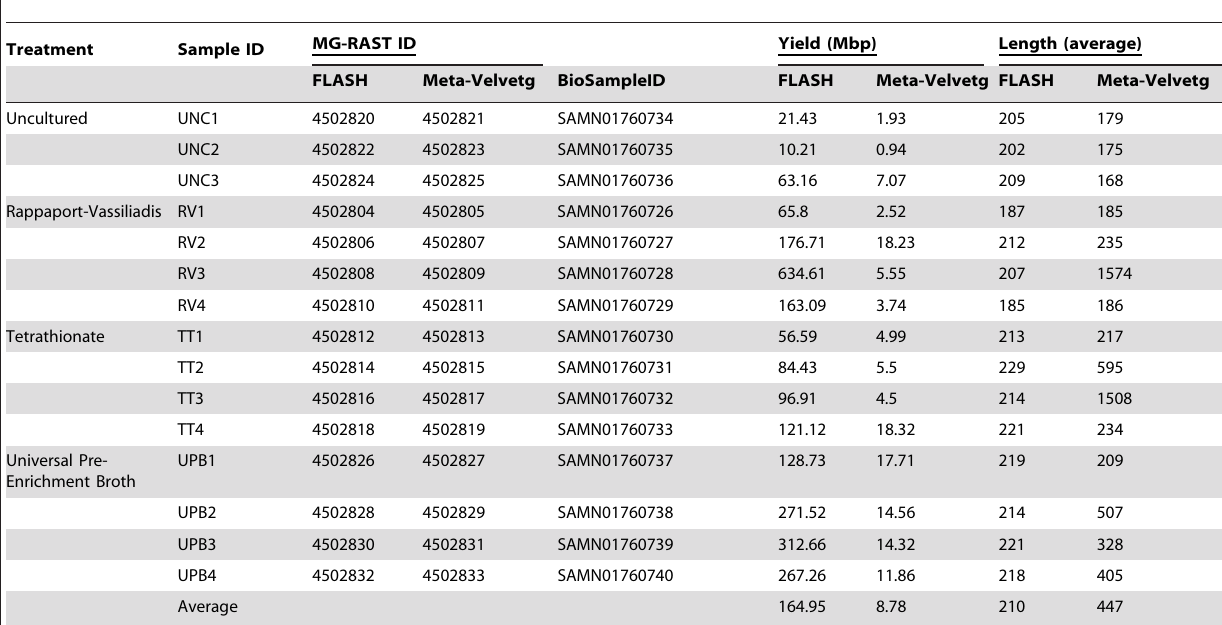
Table 1. MG-RAST ID, BioSampleID, total number of bases (Yield), and average length of sequences per sample, of the 15 metagenomes for both the FLASH and Meta-Velvetg assembly methods.